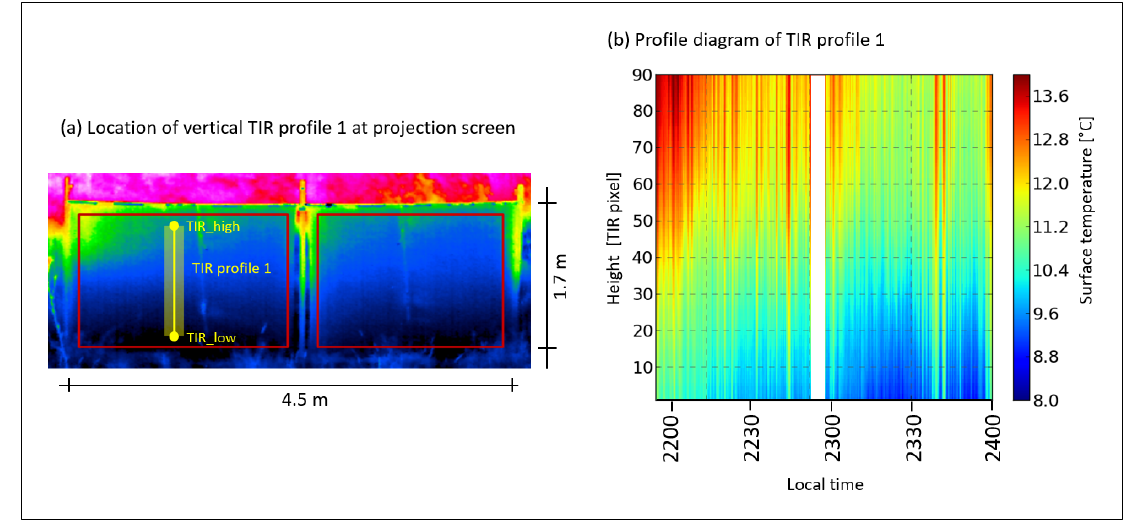
Figure 5. PS data overview on 23 July 2012: ( a ) PS TIR image from the location of vertical TIR profile 1 and TIR data points TIR_low and TIR_high (from Figure 4), usable PS surface starts at 20 cm above ground; ( b ) profile diagram of TIR profile 1 from 21:50–24:00 LT with 90 TIR data points (pixel) for a height of 150 cm starting at 20 cm above ground, TIR interval = 1 s, white color means no data.